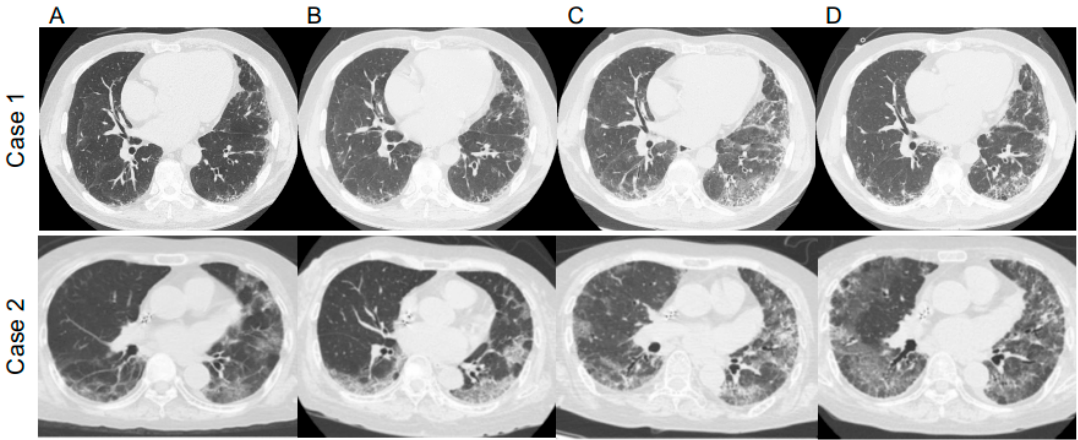
Figure 2. Chest computed tomography (CT) images of Case 1 and Case 2 ( A ) at COVID-19 diagnosis, ( B ) after treatment of COVID-19, ( C ) at Pneumocystis jirovecii pneumonia (PJP) diagnosis, and ( D ) after PJP treatment with trimethoprim–sulfamethoxazole.